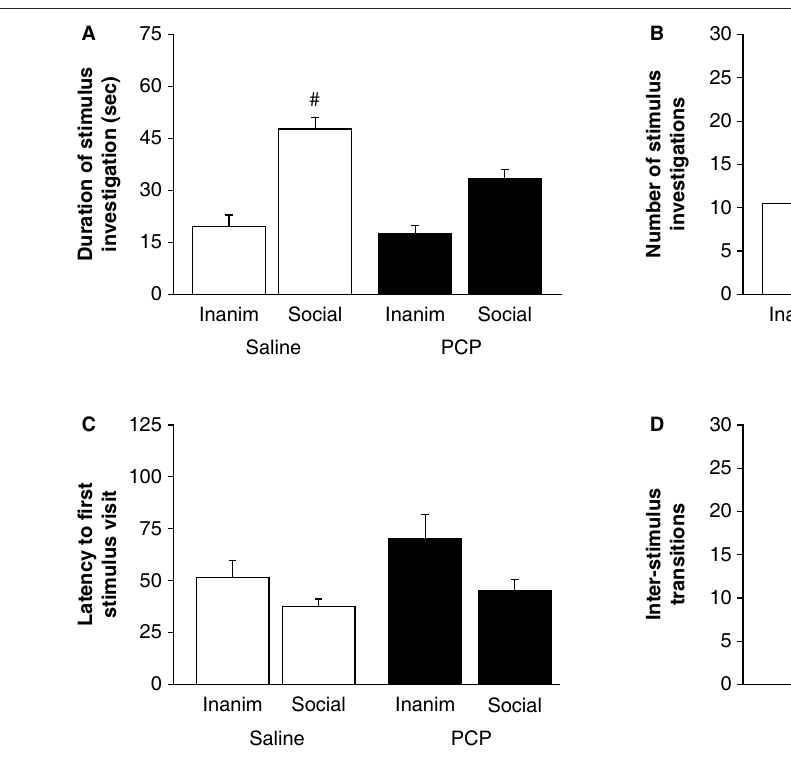
FIGURE 2 | Effects of subchronic PCP treatment on social novelty preference in C57BL/6J mice. Mice subchronically treated with either PCP or saline spent signifi cantly more time investigating (A) and made signifi cantly more investigations of (B) the novel social stimulus than the familiar social stimulus. Neither treatment